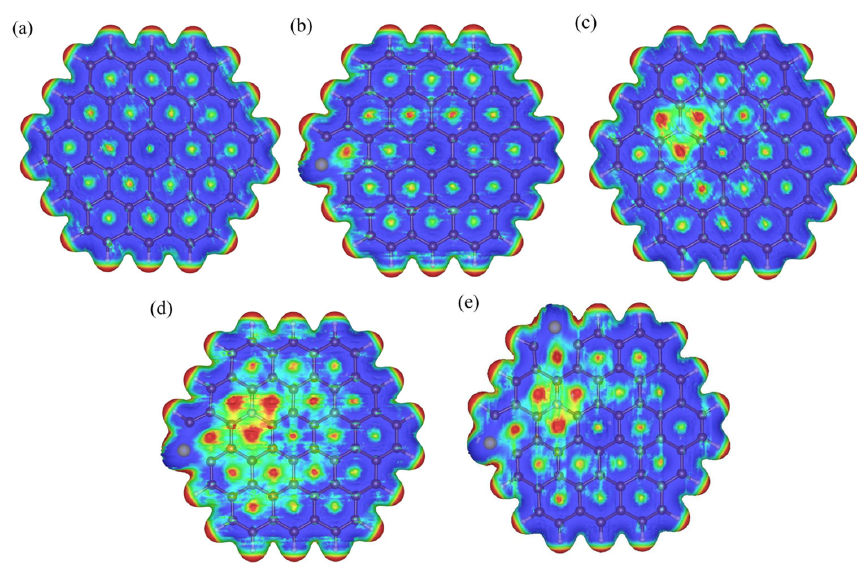
Figure 4. Electrostatic mappings of ( a ) pristine graphene, ( b ) S-doped, ( c ) N-doped (graphitic nitrogen), ( d ), S-, N-codoped, and ( e ) S-, S-, N-doped graphene models. Reprinted with permission from reference [70].